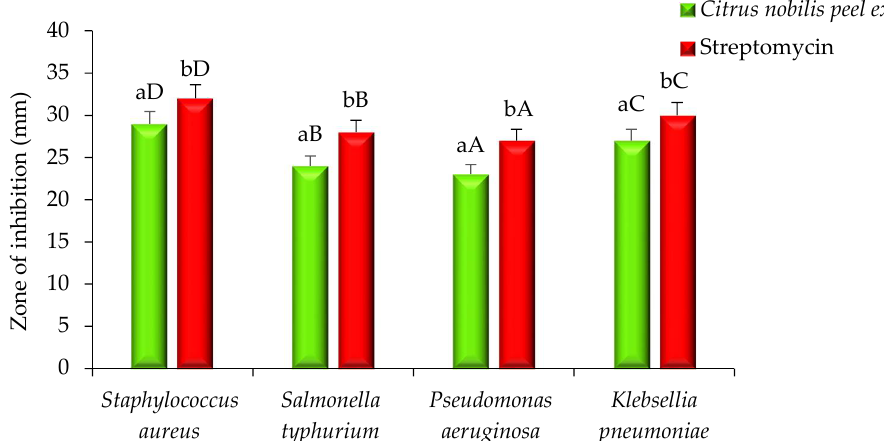
Figure 2. Antibacterial activity (zone of inhibition) of Citrus nobilis peel dry extract against Gram-positive and Gram-negative bacteria. Data are presented as means ± SEM ( n = 3); a,b: Means within the column with different lowercase superscripts are significantly different ( p < 0.05); A–D: Means within the row with different uppercase superscript are significantly different ( p < 0.05) from each other.